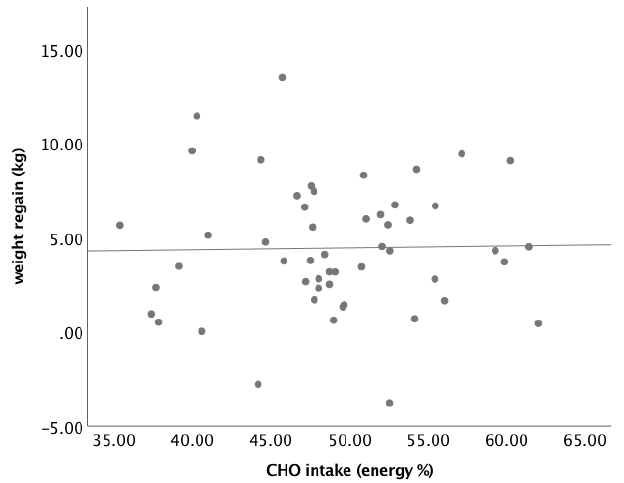
Figure 2. Association between dietary carbohydrate (CHO) intake during follow-up (FU) and weight regain ( n = 52).